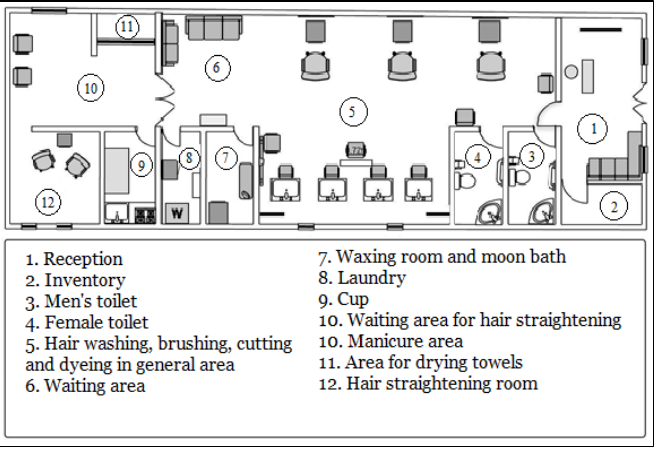
Figure 2: Beauty salon layout and its operations.